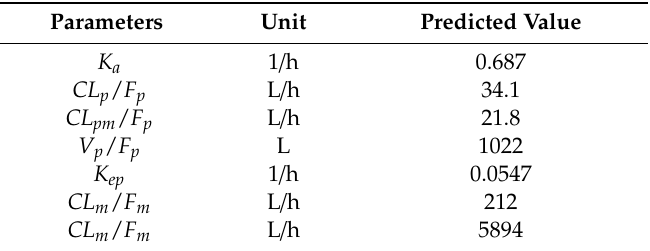
Table 3. Predicted PK parameters of DLX and 4-HD in humans extrapolated from rats and experimental human parameters in